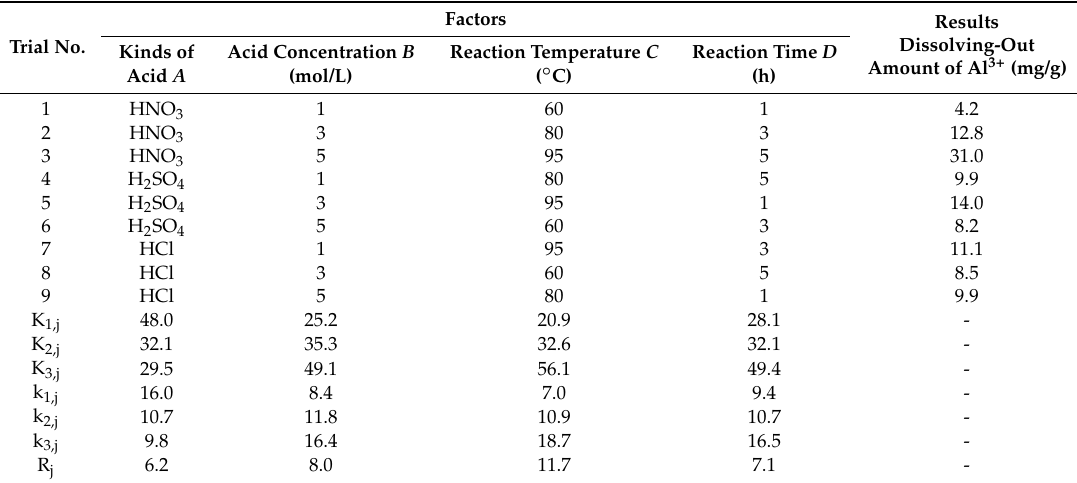
Table 5. Design and results of the orthogonal experiment of acid treatment of sericite a . Factors Results Dissolving-Out Trial No. (mg/g)Kinds of Acid Concentration B Reaction Temperature C Reaction Time D Amount of Al 3+ Acid A (mol/L) ( ◦ C)